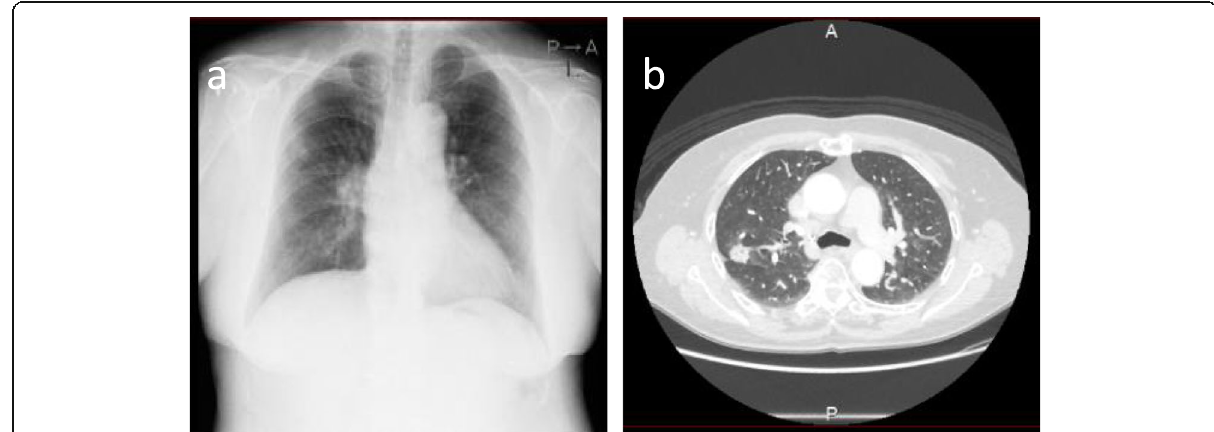
Fig. 1 An abnormal chest shadow can be seen on a chest roentgenogram in the right upper lung field ( a ). A chest computed tomography scan showed an abnormal lesion, 2.6 × 2.4 cm in size, in the right upper lobe ( b )